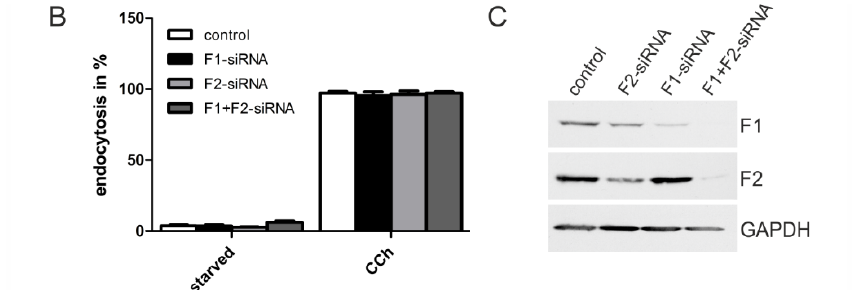
Figure 3. Knockdown of flotillin-1 and flotillin-2 has no impact on M 2 receptor internalization. ( A ) HEK 293T cells were depleted of flotillin-1 (F1), flotillin-2 (F2) or both (F1 + F2) by specific siRNAs and transfected with M 2 -EGFP. The cells were starved for 18 h in serum-free medium and either left untreated or stimulated with 1 mM CCh for 15 min. Cells were fixed and immunostained for flotillin-1 and flotillin-2. The nuclei were stained with DAPI (shown in blue). Scale bars: 10 μ m; ( B ) The fraction of cells displaying M 2 receptor internalization was quantified and is shown as the percent of cells showing intracellular M 2 localization. At least 100 cells were counted per condition. Results are shown as the mean ± SD.